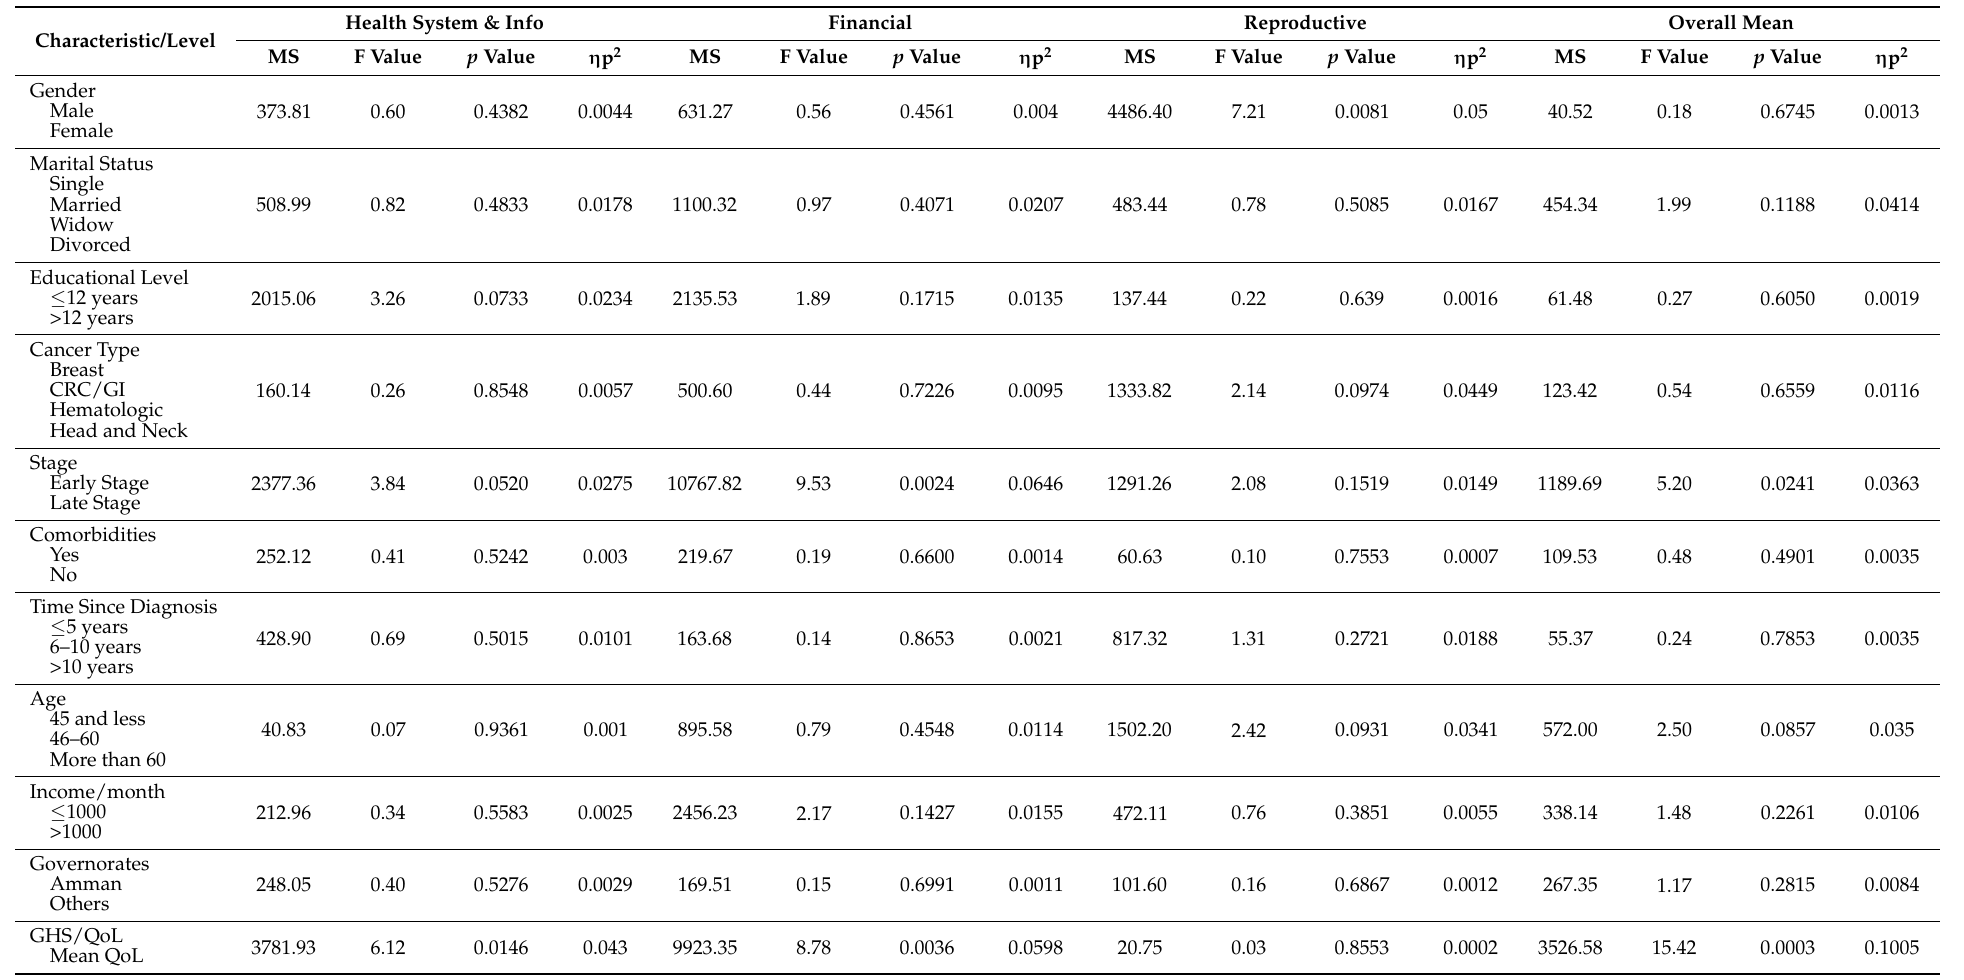
Table 6. Multivariate linear regression of mean scores of Health System and Information, Financial, Reproductive domains and overall specific needs on the modified SCNS-SF (45